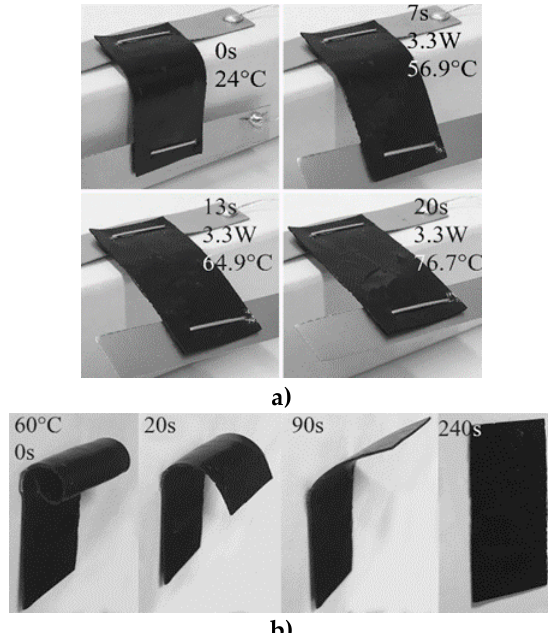
Figure 7. The time-dependent shape memory recovery of the MWCNT nanopaper / epoxy strip after ( a ) Joule heating to 76.7 ◦ C (3.3 W), ( b ) heating in an oven to 60 ◦ C. The respective temperatures, electric power, and times are included in the figure.